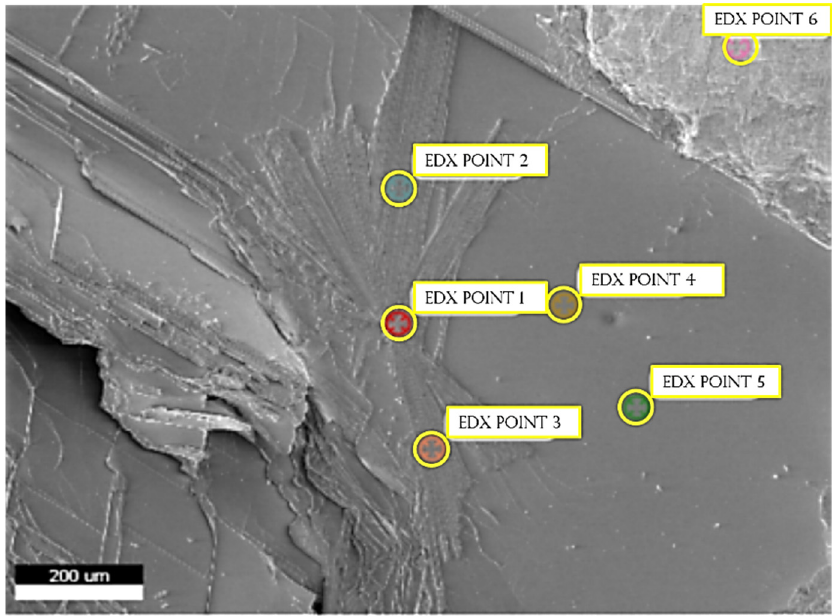
Figure 7. Gypsum crystal partly dehydrated, cleaved along cleavage plane, with observable dihy- drate, α -hemihydrate and β -hemihydrate. Yellow circle = still dihydrate, blue circle = alpha hemi- hydrate, red circle = beta hemihydrate, black arrow = alpha hemihydrate growing direction of a needle like crystal Points 4 and 5 are comparable to the gypsum crystal without heat treatment. The measured values did not perfectly fit the calculated values because of the error of meas- urement of EDX.